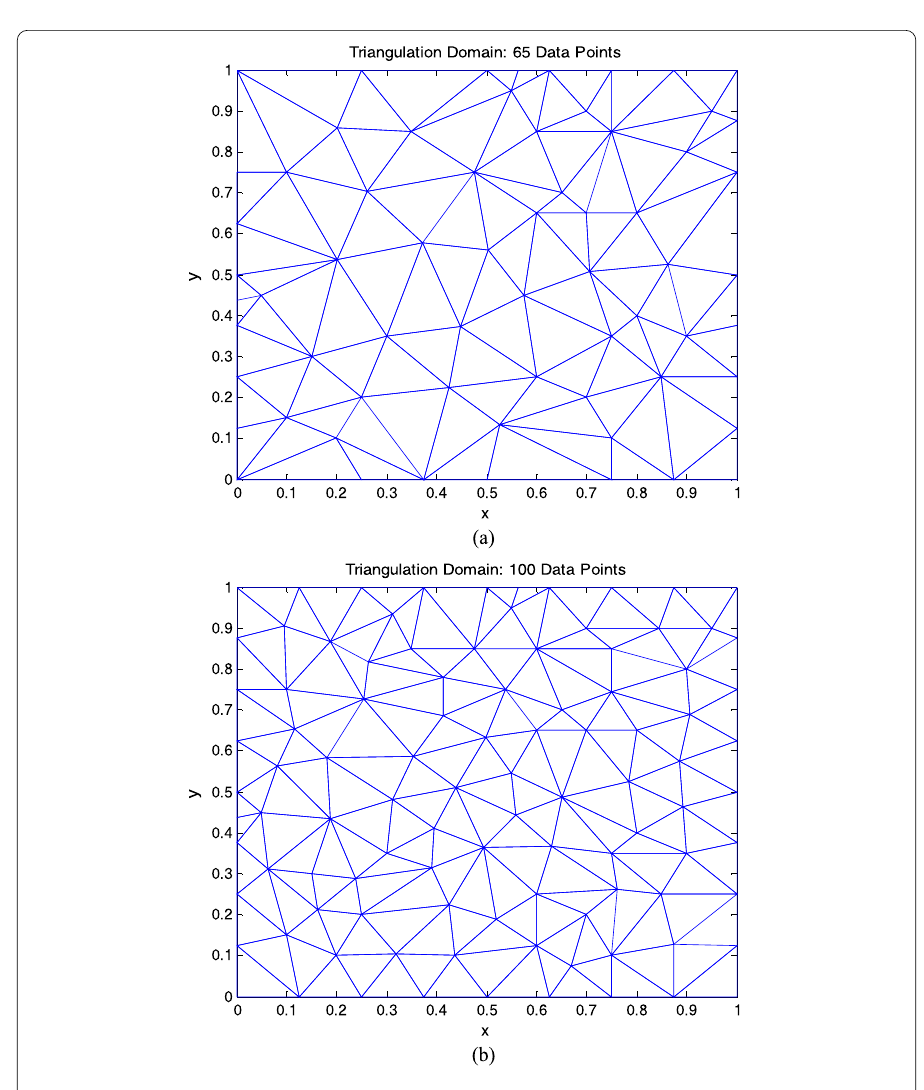
Figure 10 Triangulation domain of ( a ) 65 data points; ( b ) 100 data points on square grid [0,1] × [0,1]